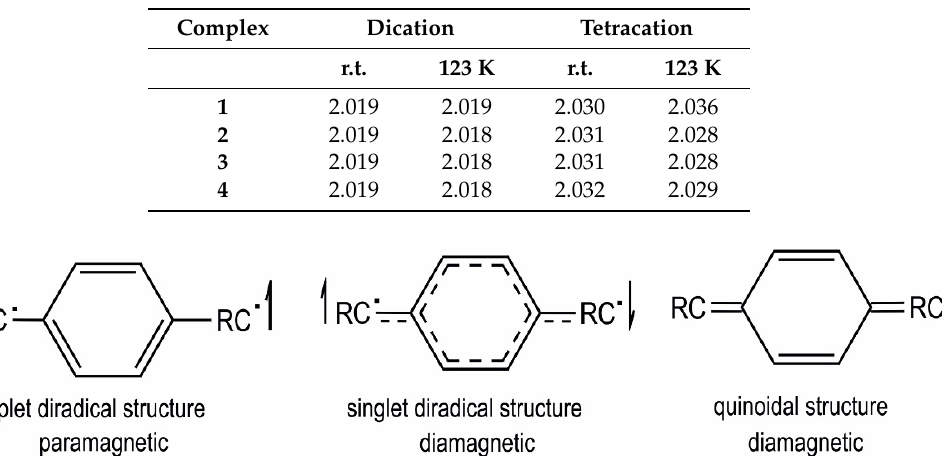
Table 3. g values for oxidized complexes 1 – 4 in CH 2 Cl 2 .